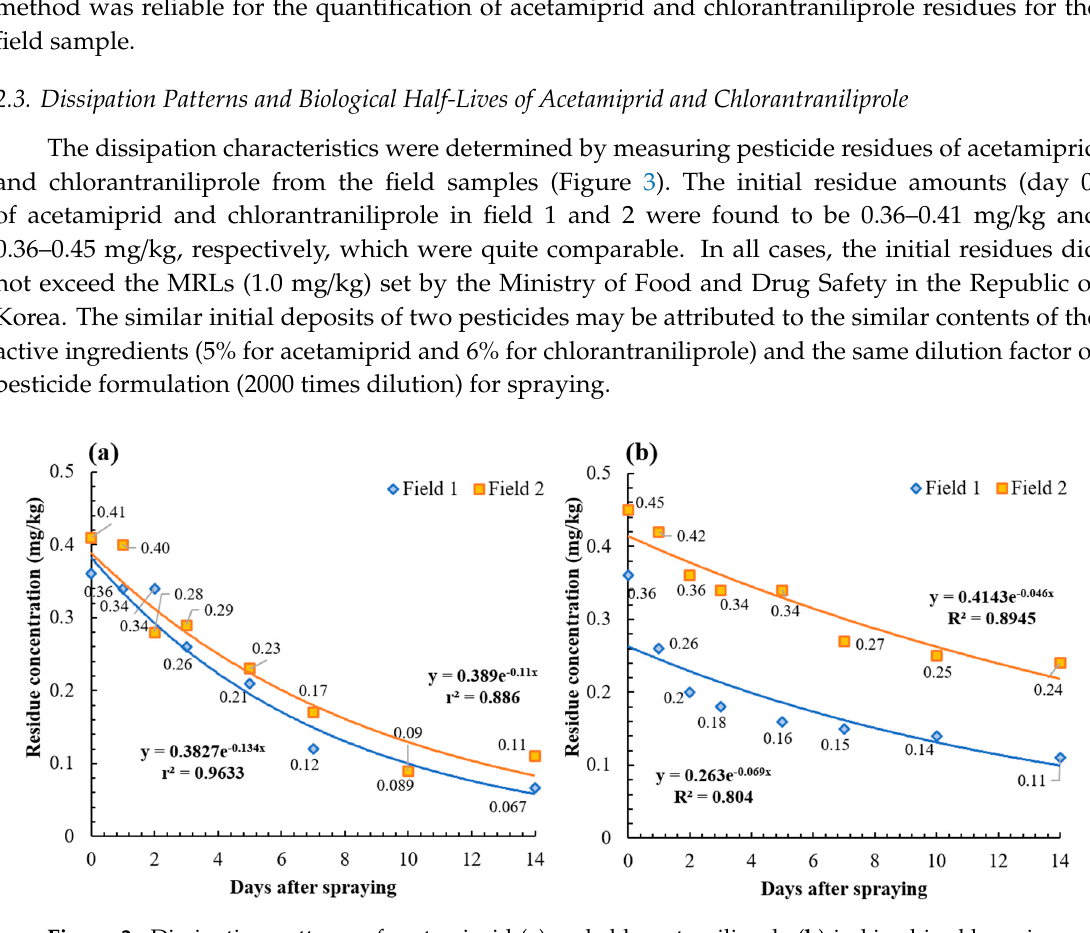
Figure 3. Dissipation patterns of acetamiprid ( a ) and chlorantraniliprole ( b ) in kimchi cabbage in fields 1 and 2.